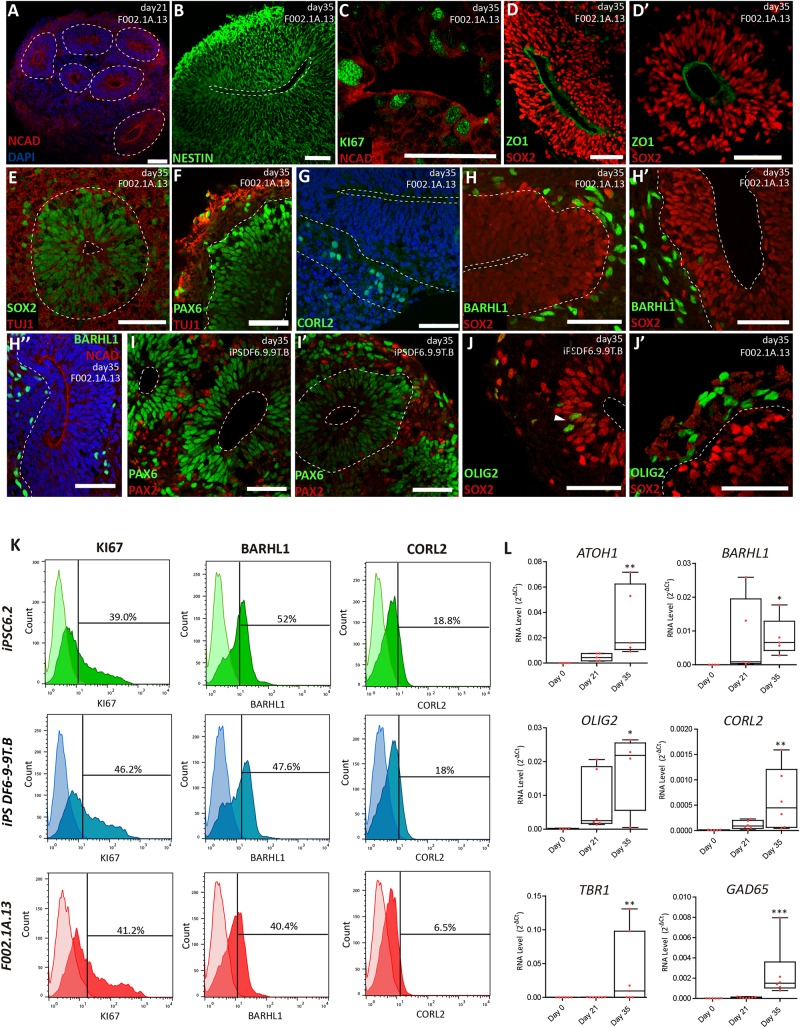
Cerebellar progenitors self-organize into structures reminiscent of the neural tube. (A–J) Immunofluorescence analysis on days 21 and 35 of differentiation of the indicated iPSC lines. Blue staining corresponds to nuclei labeled with DAPI. (A) Dashed lines delineate neural rosettes containing a lumen-like center marked by N-Cadherin (NCAD). (B) Neuro-epithelial rosette stained for Nestin. (C) Proliferating cells positive for KI67 located close to the lumen marked by NCAD. (D,D’) Apical layer of SOX2 positive cells surrounding the lumen marked by ZO1, a tight junction protein. (E) Dashed lines delineate the lumen and the boundary between the apical layer of SOX2 positive cells and the basal layer containing cells expressing neuron-specific class III beta-tubulin (TUJ1). (F) Dashed line delineates the boundary between the apical layer of PAX6 positive cells and the basal layer containing cells expressing TUJ1. (G) Dashed lines delineate the lumen and the boundary between the apical and basal layers; cells stained green express CORL2, a marker of Purkinje cell precursors. (H,H’) Dashed lines delineate the lumen and the boundary between the apical layer of SOX2 positive cells and the basal layer containing cells expressing BARHL1, a marker for granule cell precursors. (H”) Dashed line delineates the boundary between the apical layer (lumen marked by NCAD) and the basal layer containing cells expressing BARHL1. (I,I’) Dashed lines delineate the lumen and the boundary between the apical layer of PAX6 positive cells and the basal layer containing cells expressing PAX2, a marker for GABAergic interneurons. (J) Dashed line delineates the lumen; arrowhead indicates cells expressing OLIG2 (a marker for newly formed Purkinje cells) interspersed among SOX2 positive cells. (J’) Dashed line delineates the boundary between the apical layer of SOX2 positive cells and the basal layer containing cells expressing OLIG2. Scale bars, 50 μm. (K) Flow cytometry analysis of cells expressing KI67, BARHL1 and CORL2 on day 35 of differentiation of the indicated iPSC lines (n = 3 per marker). (L) qRT-PCR analysis of cultures derived from F002.1A.13 cells at the indicated time points. The graphs depict mRNA expression levels (2–ΔCt) relative to GAPDH. Each dot represents data from an independent experiment (n = 5). One-way ANOVA (Dunn’s Multiple Comparison Test), ∗p < 0.05, ∗∗p < 0.01, ∗∗∗p < 0.001; error bars represent SEM.